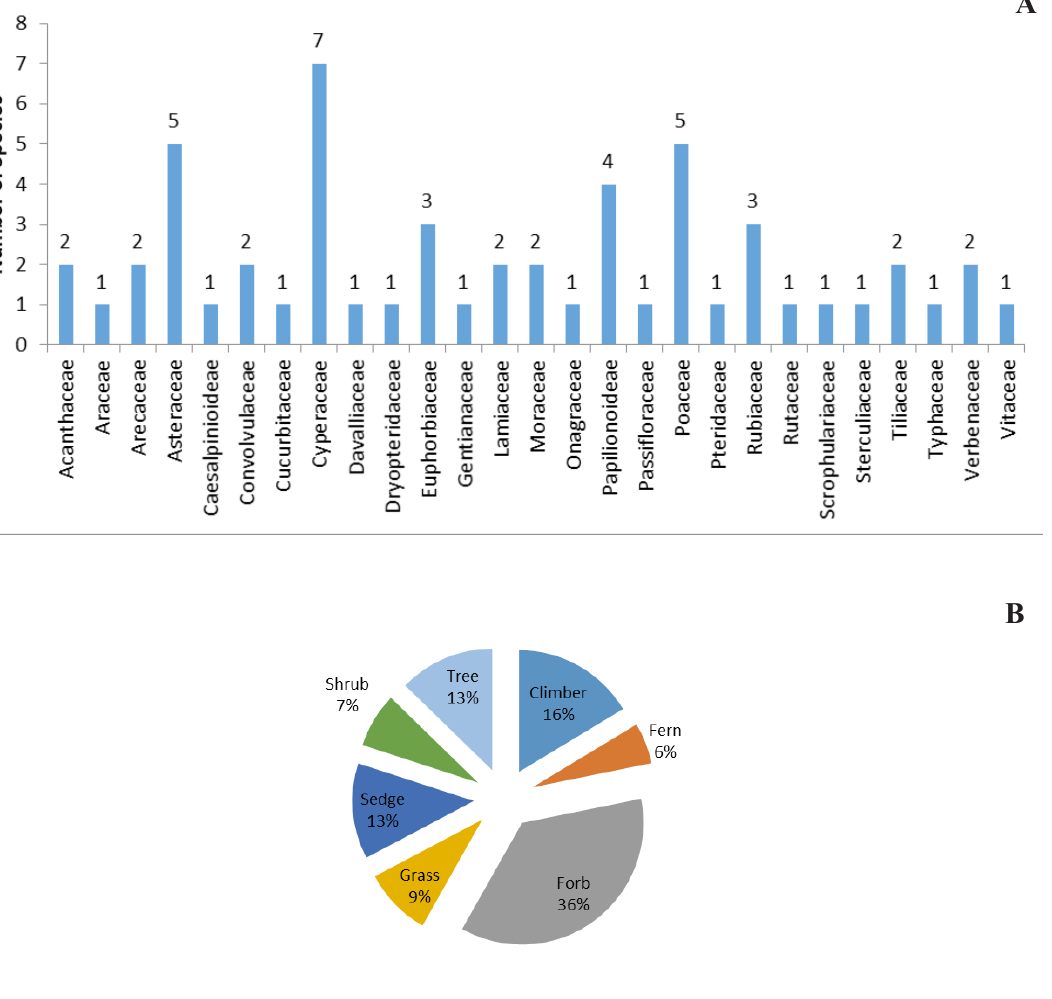
Figure 3. Distribution of species in Badagry, Lagos state, Nigeria. A: Family distribution; B: Percentage distribution of Plant